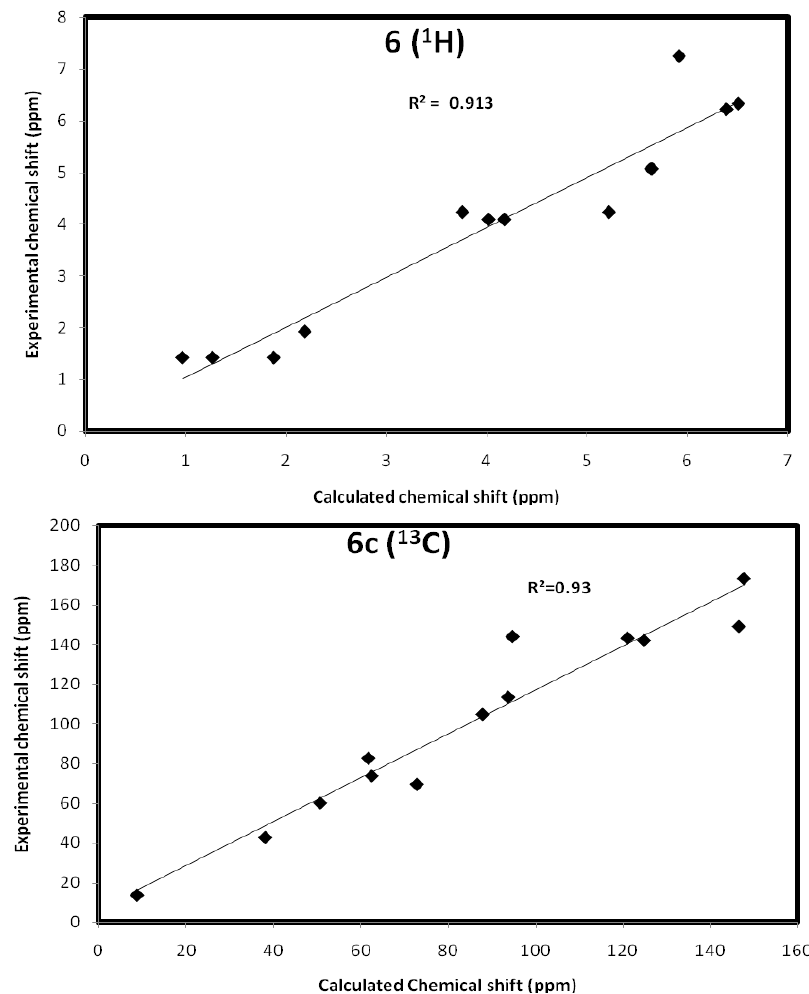
Figure 7. The correlation graphs between the calculated and experimental chemical shifts compound 6 . On the other hand, this reaction was extended for the cycloaddition reaction of 1-(propergyl) pyridinium-3-olate 1 with diphenylacetylene as symmetric dipolarophile to afford only two products, 6,7-diphenyl-8-(prop-2-ynyl)-8-aza-bicyclo(3.2.1)octa-3,6-dien-2-one 10 as major product and